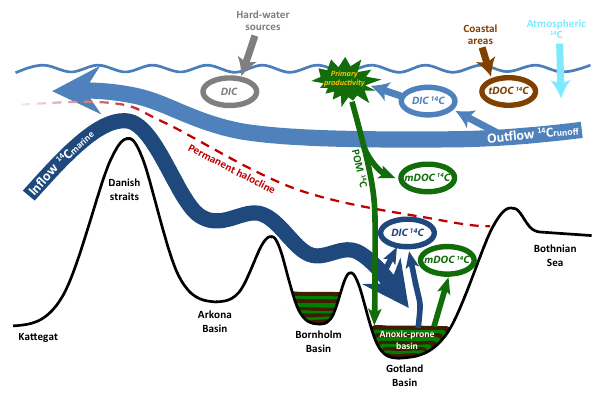
Fig. 2. Graphical representation of various 14 C source pathways within the Baltic Sea (see text for detailed explanation). Abbre- viations are as follows: tDOC=terrestrial dissolved organic car- bon, DIC=dissolved inorganic carbon, mDOC=marine dissolved organic carbon, and POM=particulate organic